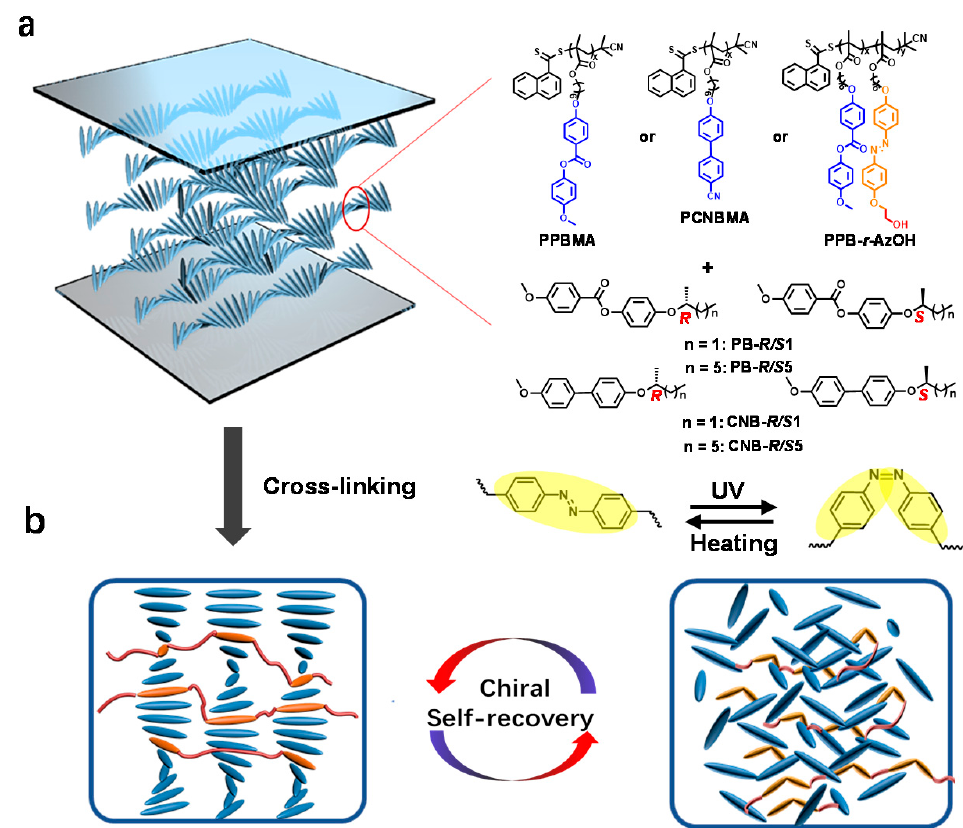
Figure 1. ( a ) Schematic representation of the chiral nematic phase formed from the achiral polymers and chiral dopants. ( b ) Process of the locking and self-recovery of the induced chirality. Table 1. Molecular weight characteristics of liquid crystalline polymers.